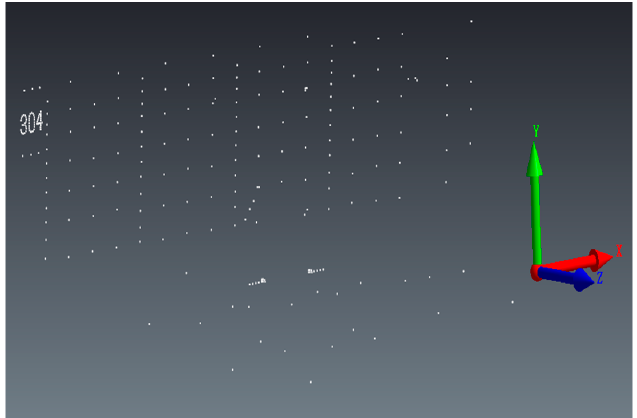
Figure 9. Test control field.